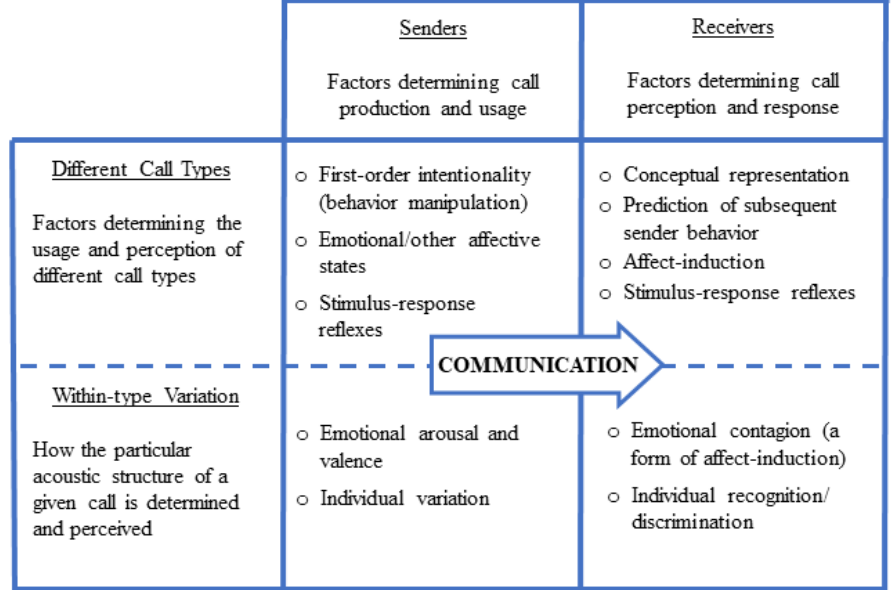
Figure 1 . Organization of two distinctions leading to four broad questions. Each quadrant includes a brief, non-exhaustive list of proximate mechanisms supported by the literature. The processes listed are not mutually